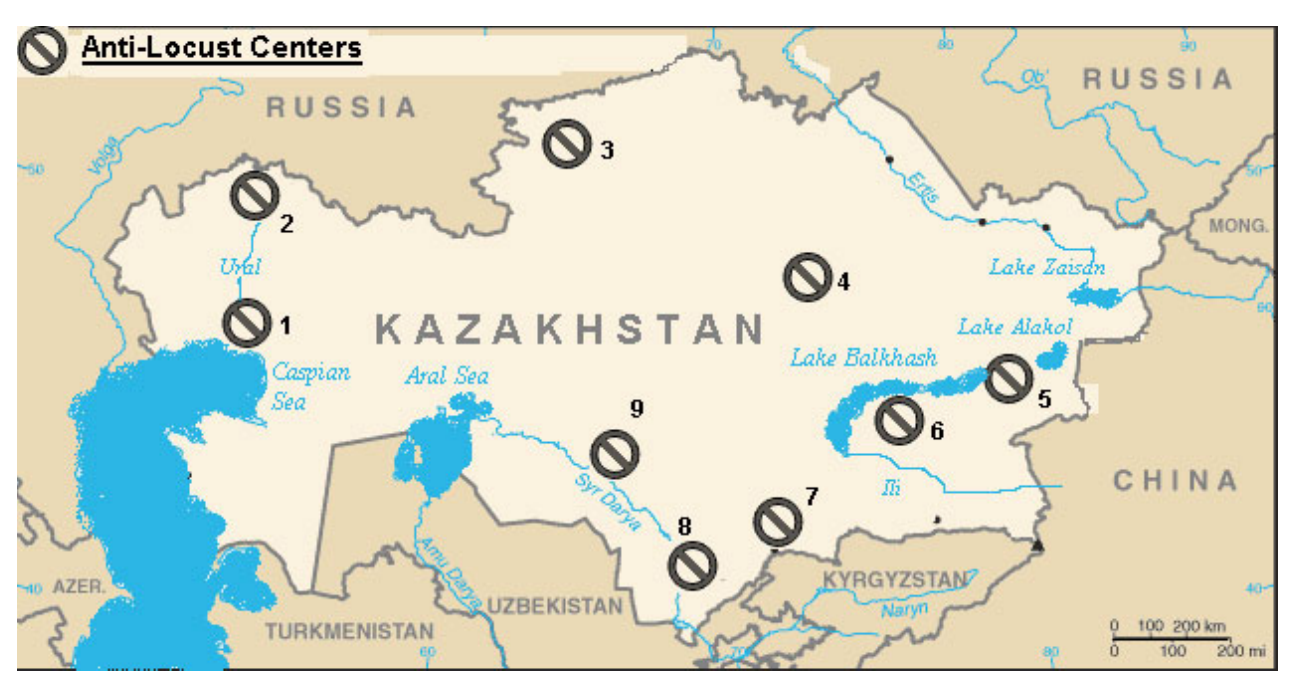
Fig. 2. Anti-Locust Centers in Kazakhstan existing in